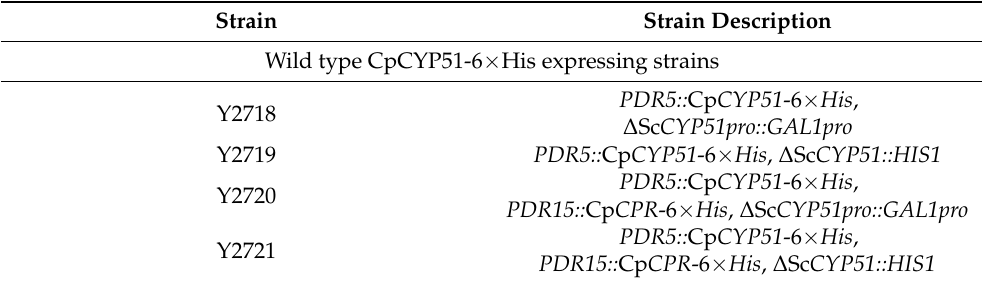
Table 1. List of strains prepared in the present study. Strain Strain Description Wild type CpCYP51-6 × His expressing